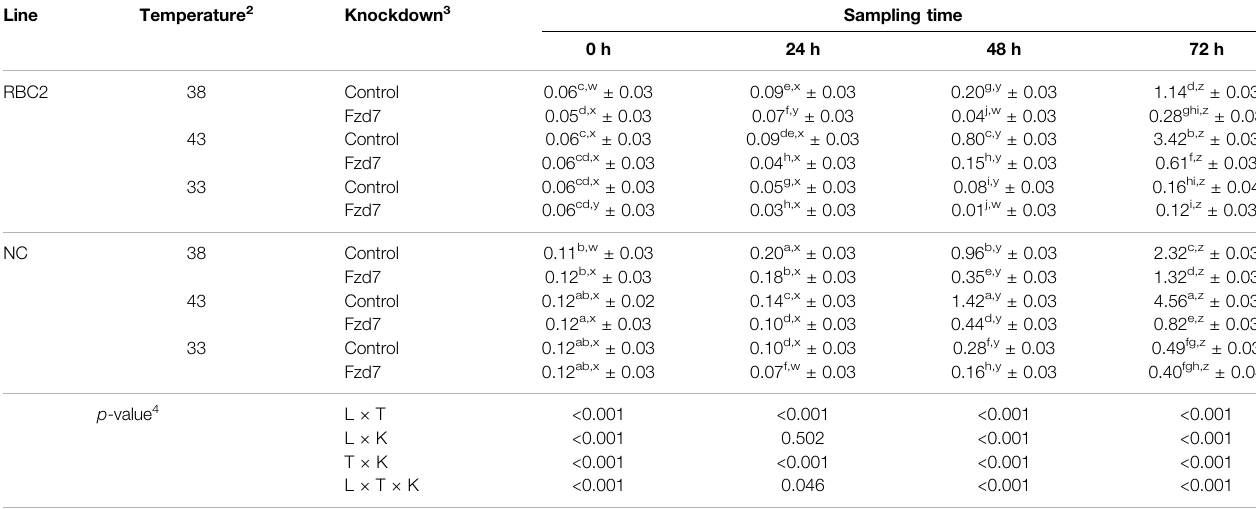
TABLE 5 | Effect of temperature and knockdown of frizzled-7 ( Fzd7 ) on lipid content during proliferation of randombred control line 2 (RBC2) and modern commercial line (NC) satellite cells 1 . Line